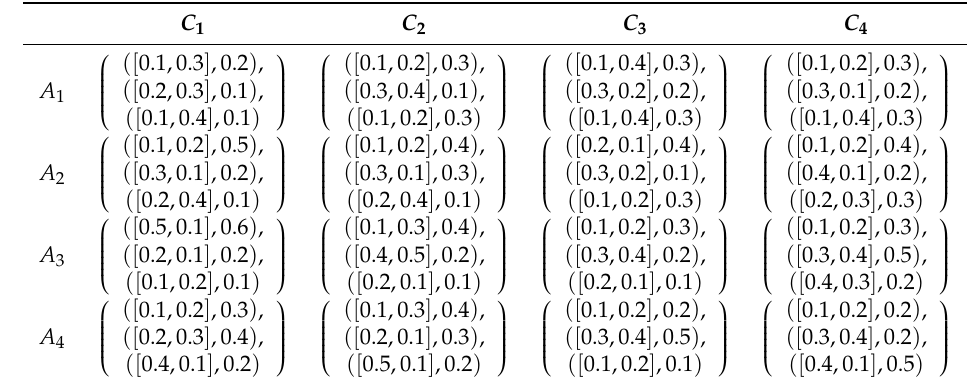
Table 3. Third decision-maker